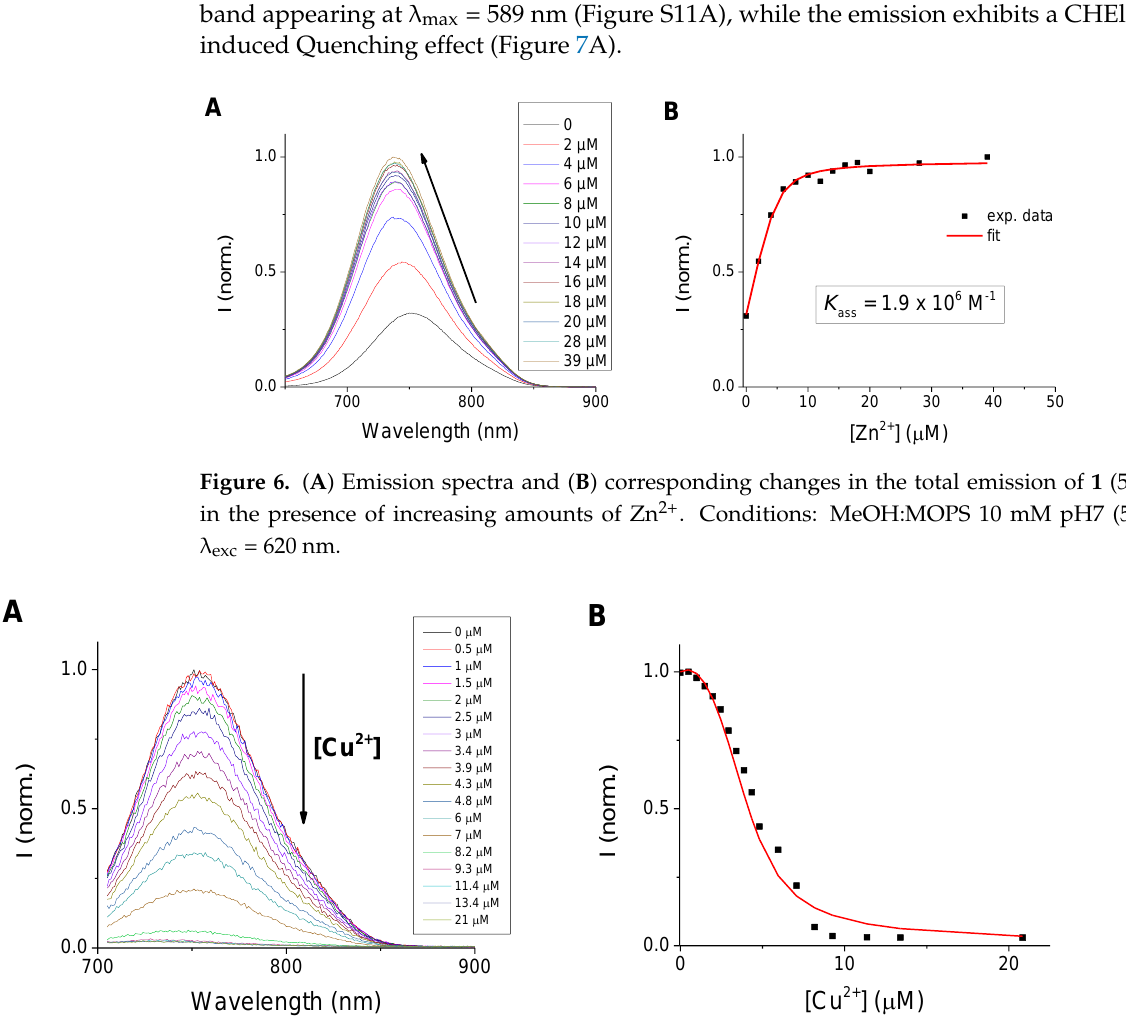
Figure 7. ( A ) Emission spectra and ( B ) corresponding changes in the total emission of 1 (5 µM), in the presence of increasing amounts of Cu 2+ . The red line represents the best fit with the experimental data ( K 1 = 4.97 × 10 6 M −1 and K 2 = 1.15 × 10 5 M −1 ). Conditions: MeOH:MOPS 10 mM pH7 (50:50) ; λ exc = 680 nm.